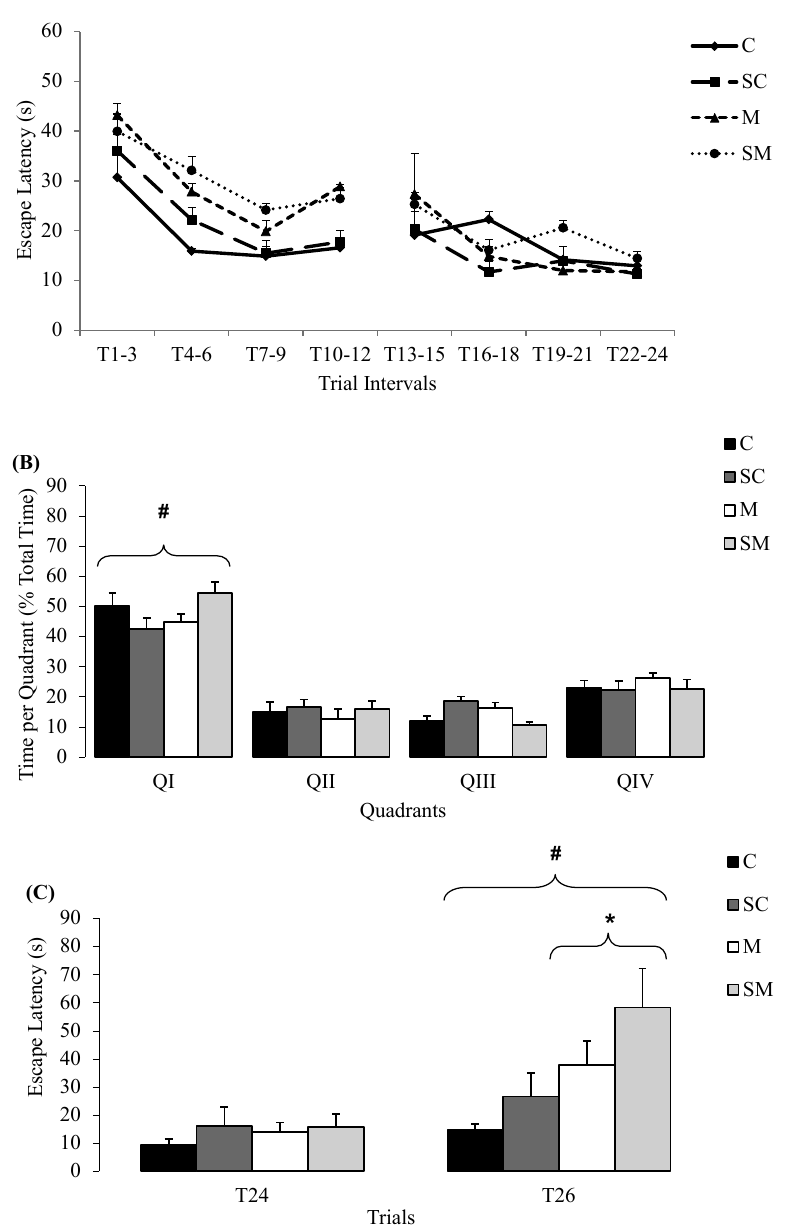
Figure 1 . A: Escape latency (Mean + SEM) of the 4 groups in Experiment I, C ( n =14), SC ( n =14), M ( n =12), SM ( n =12), in the 24 trials of the fi rst phase of MWM test. B: Percent time spent in each of the four quadrants of the MWM (Mean + SEM) by animals of the four groups on probe trial in Experiment I. * p <.05 compared to the other groups in QI; # p <.05 compared to time spent in QII, QIII e QIV (Newman-Keuls test). C: Escape latency (Mean + SEM) of the 4 groups in Experiment I, in the last trial of the fi rst phase (24 th trial) and 28 days later (26 th trial). # p <.05 compared to 24 th trial; * p <.05 compared to escape latency of the same groups (M and SM) in 24 th trial (Newman-Keuls